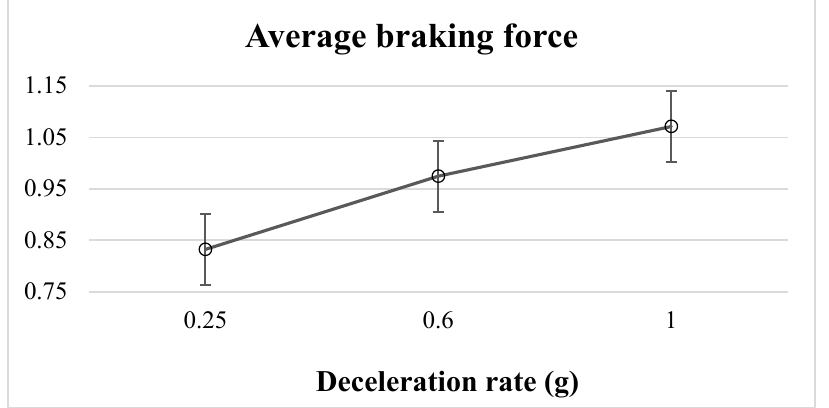
Figure 5. Braking response force for three deceleration rates in the 50 km/h driving environment.